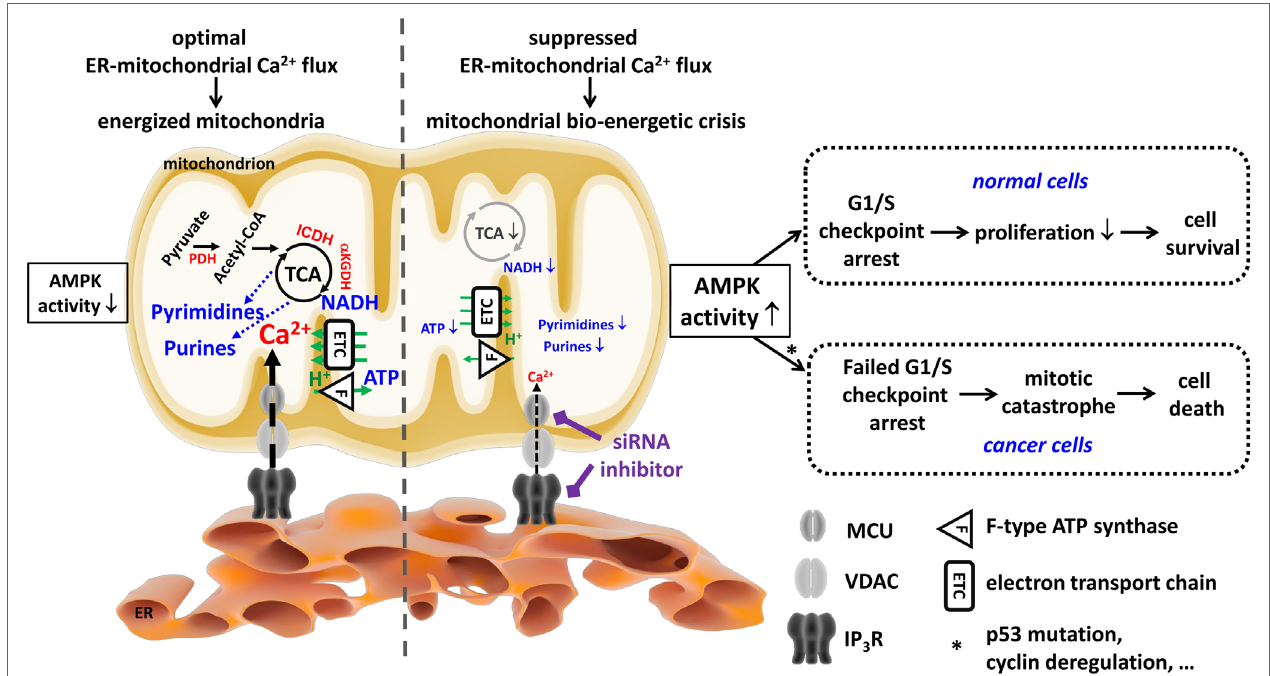
FiGURe 2 | Cancer cells are addicted to endoplasmic reticulum (eR)–mitochondrial Ca 2 + fluxes to produce tricarboxylic acid (TCA)-dependent mitochondrial substrates used to sustain their uncontrolled proliferation . In both non-malignant and malignant cells, mitochondria require Ca 2 + from the ER Ca 2 + store for an adequate performance of the TCA cycle, which ultimately leads to energy production (ATP), redox homeostasis (NADH), and anabolism, e.g., of pyrimidine and purine nucleotides. The Ca 2 + -dependent control of the TCA cycle is due to the Ca 2 + -dependent activity of several rate-limiting enzymes (PDH, ICDH, and α KGDH, all indicated in red). Ca 2 + is efficiently delivered to the mitochondria in a quasi-synaptic manner involving Ca 2 + -signaling microdomains established at mitochondria-associated ER membranes involving inositol 1,4,5-trisphosphate receptor (IP 3 R), voltage-dependent anion channel type 1 (VDAC1), and mitochondrial Ca 2 + uniporter (MCU) as Ca 2 + -transport systems. Of note, although cancer cells switch to glycolysis for their ATP production, they too rely on functional mitochondria for the production of mitochondrial substrates used for anabolic processes, like the generation of nucleotides required for the DNA synthesis necessary for their deregulated cell cycle progression and proliferation. Ablation of these ER–mitochondrial Ca 2 + fluxes (e.g., by using siRNA-based approaches or pharmacological inhibitors like xestospongin B) results in compromised mitochondrial bioenergetics, causing a decline in ATP, NADH, and nucleotides. In both non-malignant and malignant cells, this leads to an increase in AMP-activated kinase (AMPK) activity. However, in non-malignant cells, increased AMPK activity will result in an arrest at the G1/S checkpoint, likely involving p53 activation and cyclin E downregulation, which will dampen proliferation as a cell survival strategy. In malignant cells, the link between AMPK activity and the G1/S checkpoint is lost (e.g., due to p53 mutations or cyclin deregulation). As a consequence, despite the mitochondrial bioenergetic crisis and the lack of mitochondrial substrates for DNA synthesis, cancer cells will progress toward the S phase and mitosis. This results in necrotic cell death due to mitotic catastrophe. This figure was originally published in Ref. (105). © 2016 Geert Bultynck. A copyright license to republish this figure has been